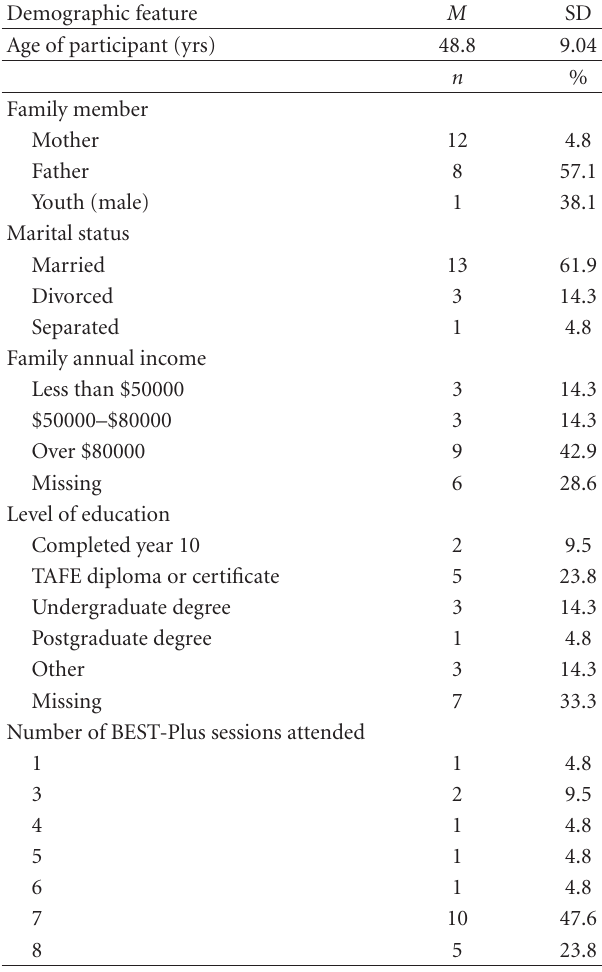
Table 1: Demographic features of participants in the consumer reference groups ( n =